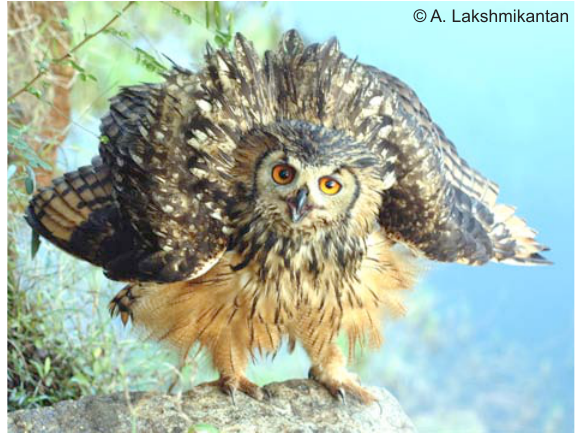
Image 8: Another phase of the transition agonistic display. This photograph shows another facet – i.e. the left wing behaving differently from the right wing. Whereas the right wing (left to the observers) shows a strong tendency towards the intimidatory display, the left wing shows a leniency towards the threat display. It is possible that in a state of strong conflicting emotions such phenomena are common.